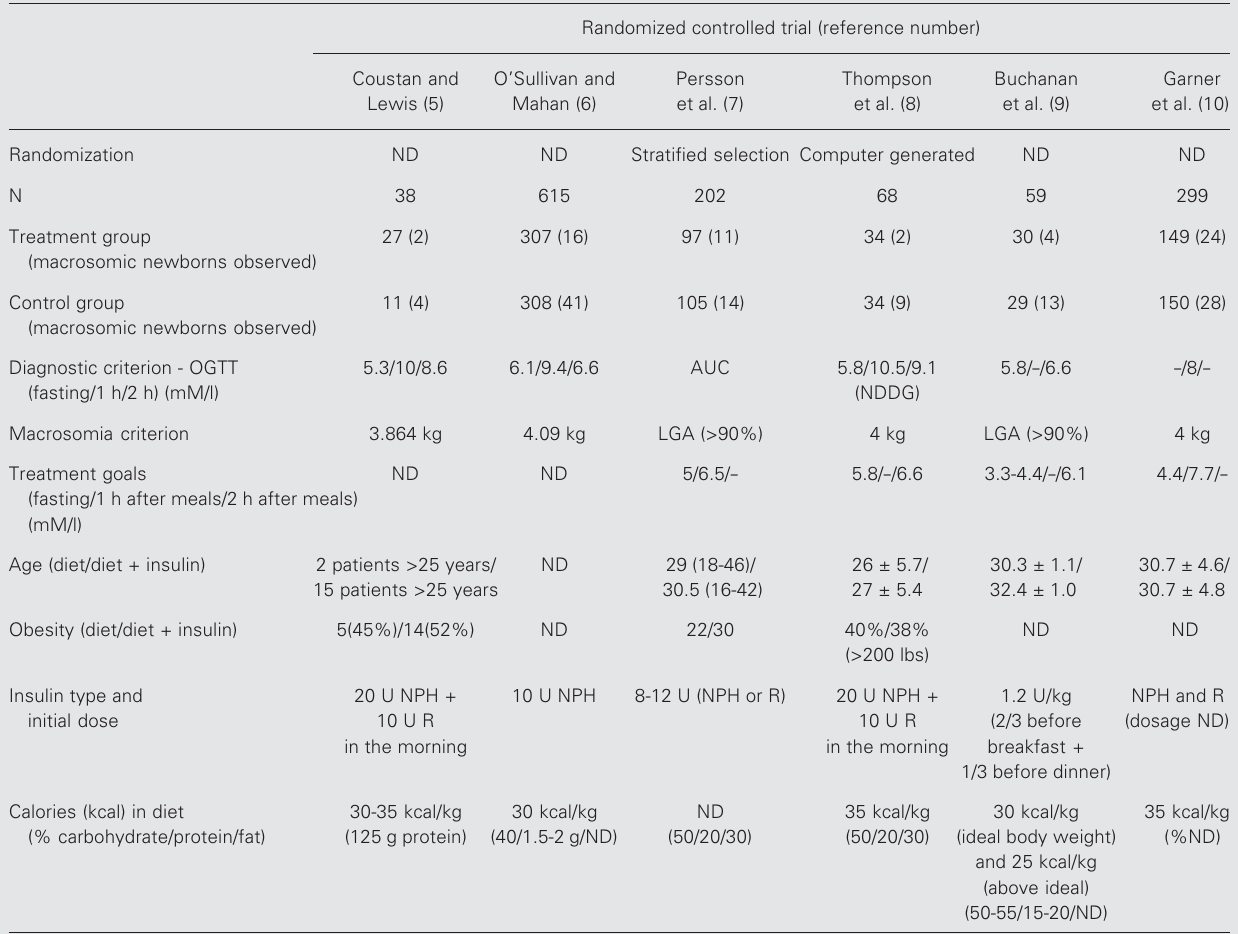
AUC = area under the curve; LGA = large for gestational age; ND = not described; NDDG = National Diabetes Data Group; OGTT = oral glucose tolerance